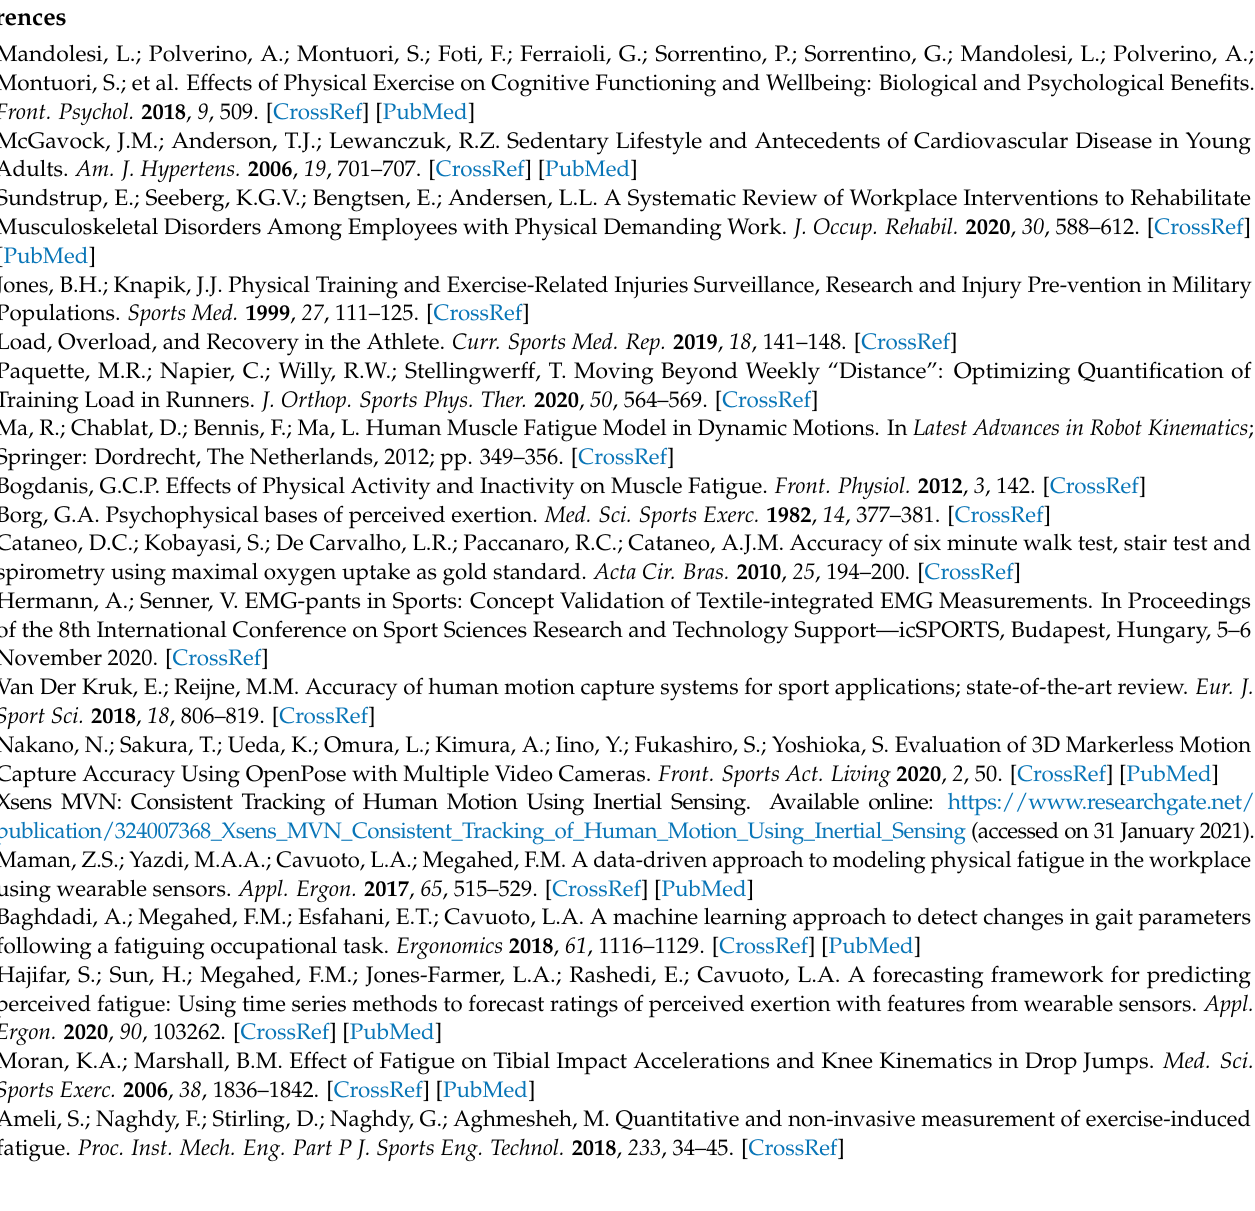
Table A3. Eligibility criteria (EC) during full-text screening phase. Articles were excluded if: EC 2.1 No primary data were collected EC 2.2 The study does not focus on individual physical exercise tasks EC 2.3 The study performed measurements spreading over multiple days The study protocol requires subject to perform power-assisted body EC 2.4 movements The study does not include kinetic or kinematic parameters for the EC 2.5 lower limbs The study lacks a fatigue inducement protocol, in particular: For protocols involving running: no running-induced fatigue (minimum of no-stop 3 km running if not stated) EC 2.6 For protocols involving static physical exercise or